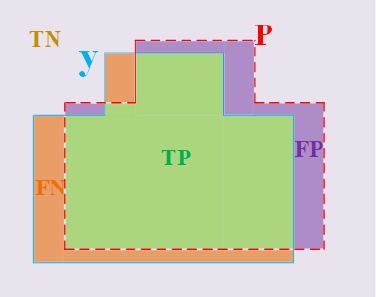
Figure 3. Illustration of y , P , TP , TN , FP and FN